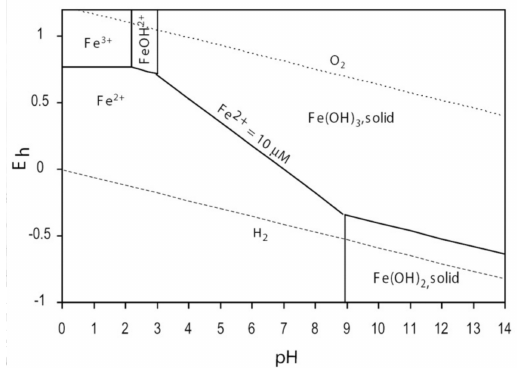
Figure 7. Pourbaix diagram for Fe(II), Fe(III), O 2 and H 2 calculated with Fe 2+ concentration of 10 µ M.